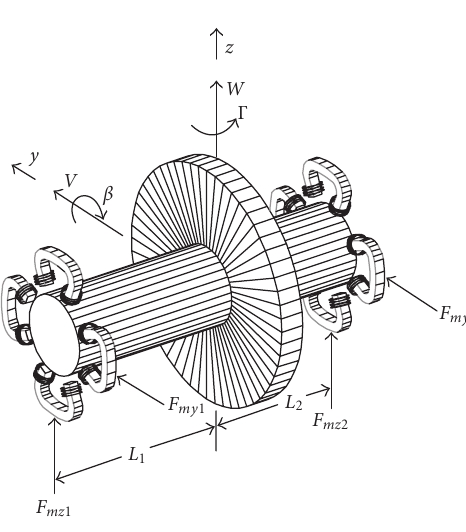
Figure 1: An 8-pole radial magnetic bearing.